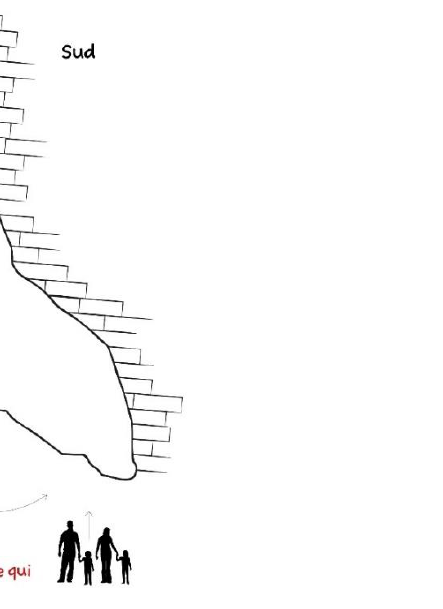
Figure 4. The second activity with a representation of the cave “Abisso Ancona” in the section.